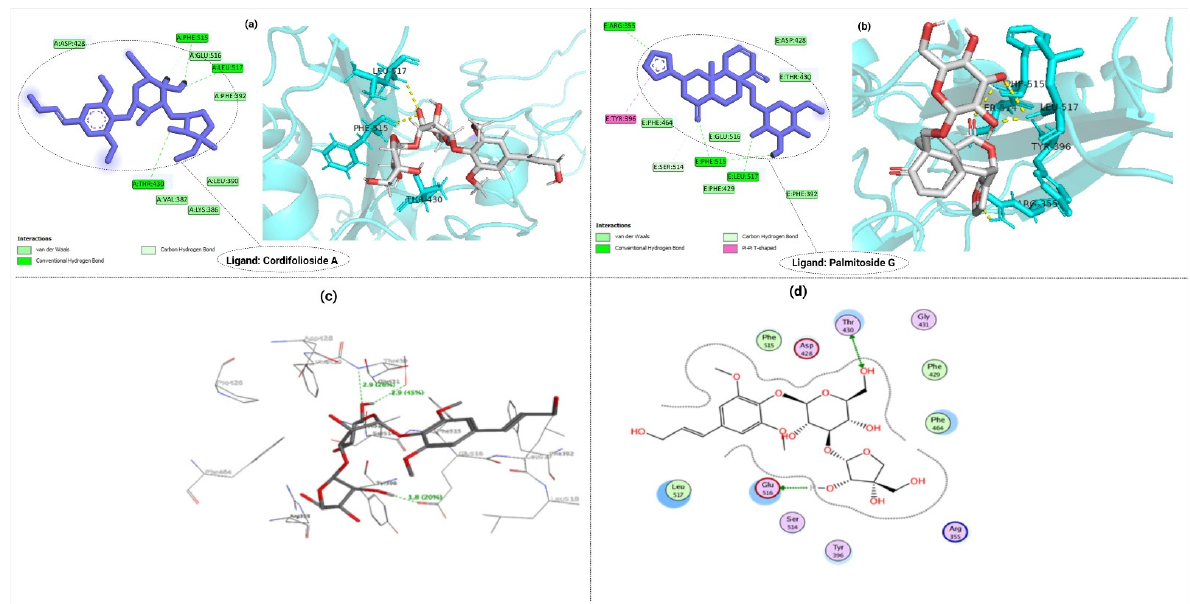
Figure 2. Interacting residues and the type of interactions of SARS-CoV-2 S1-RBD with ( a ) cordifolioside A and ( b ) palmitoside G; ( c ) 3D interaction of cordifolioside-A with SARS-CoV-2-S1-RBD; and ( d ) 2D interaction of cordifolioside A with SARS-CoV-2-S1-RBD obtained from Molecular Op- erating Environment (MOE).